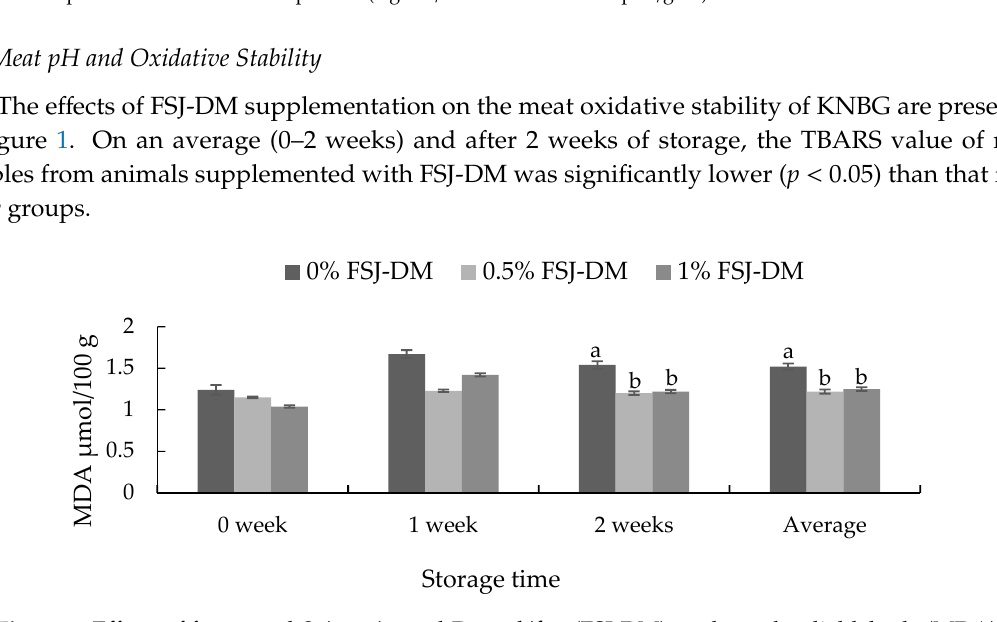
Figure 2. Effects of fermented S. japonica and D. morbifera (FSJ-DM) on the meat pH from Korean native black goats. Data are presented as mean ± SE. a, b, c Values with different superscripts in the same storage period differ significantly ( p < 0.05). 4. Discussion Phytochemicals, probiotics, prebiotics and synbiotics not only facilitate the growth performance of animals but also modulate various functions of the body. These feed additives can be suitably utilized by the animal feed industry and hold considerable promise for enhancing livestock production. Furthermore, fermentation of herbs can modify their nutritional composition and bioactivities [25] and intensify the original treatment potency due to enzymes produced by bacteria, molds and yeast [20]. In the present study, 1.0% FSJ-DM showed a tendency to increase the growth performance, oxidative stability and Σ PUFA content, while reducing the cholesterol and Σ SFA. Improvement in feed efficiency and growth performance of goats fed 1.0% FSJ-DM is thought to be induced by (i) the growth promoting effect of probiotic, including maintenance of beneficial microbial population [26]; (ii) stimulation of digestive secretions due to plant extracts [27] and (iii) improvement in health promoting properties of plants and reduction of anti-nutritional factors due